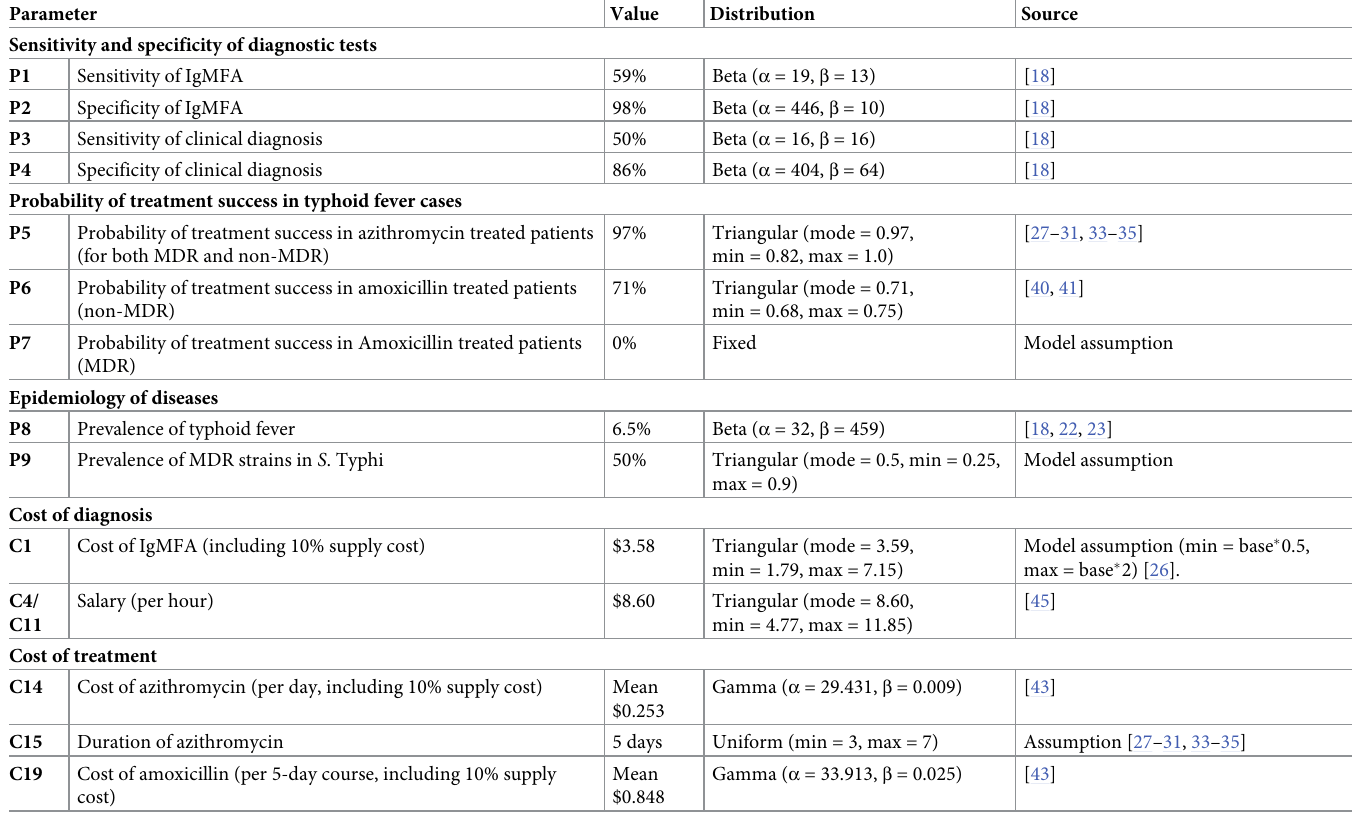
Table 3. Parameters changed in probabilistic sensitivity analysis (presented in US$,